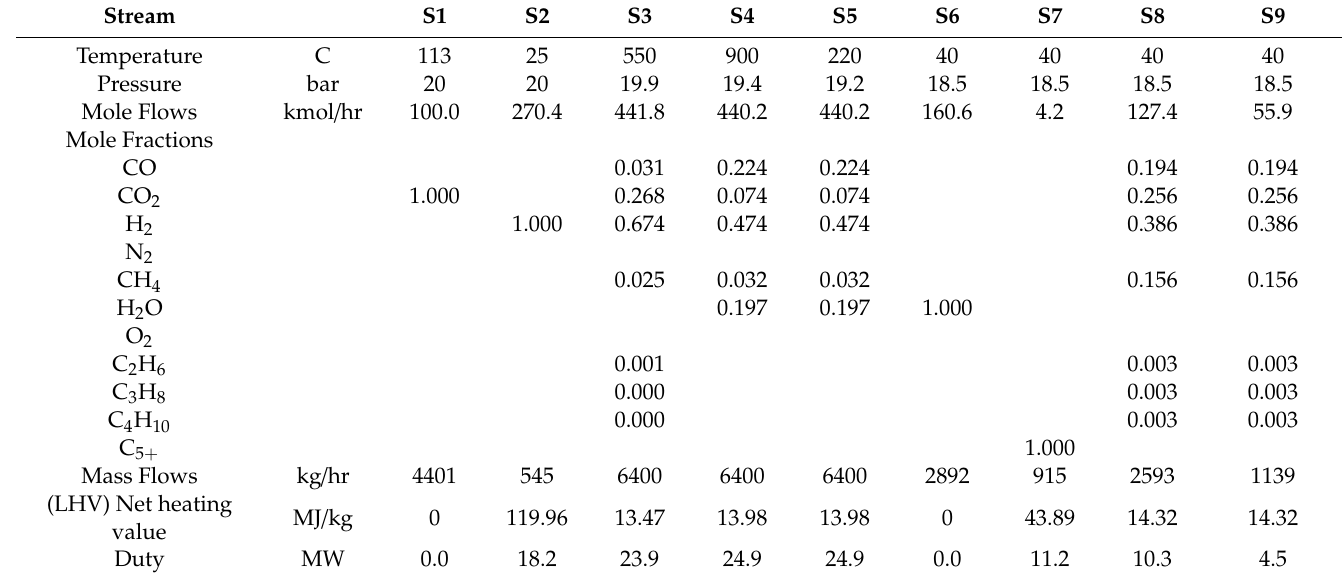
Table A4. Simulated stream results for